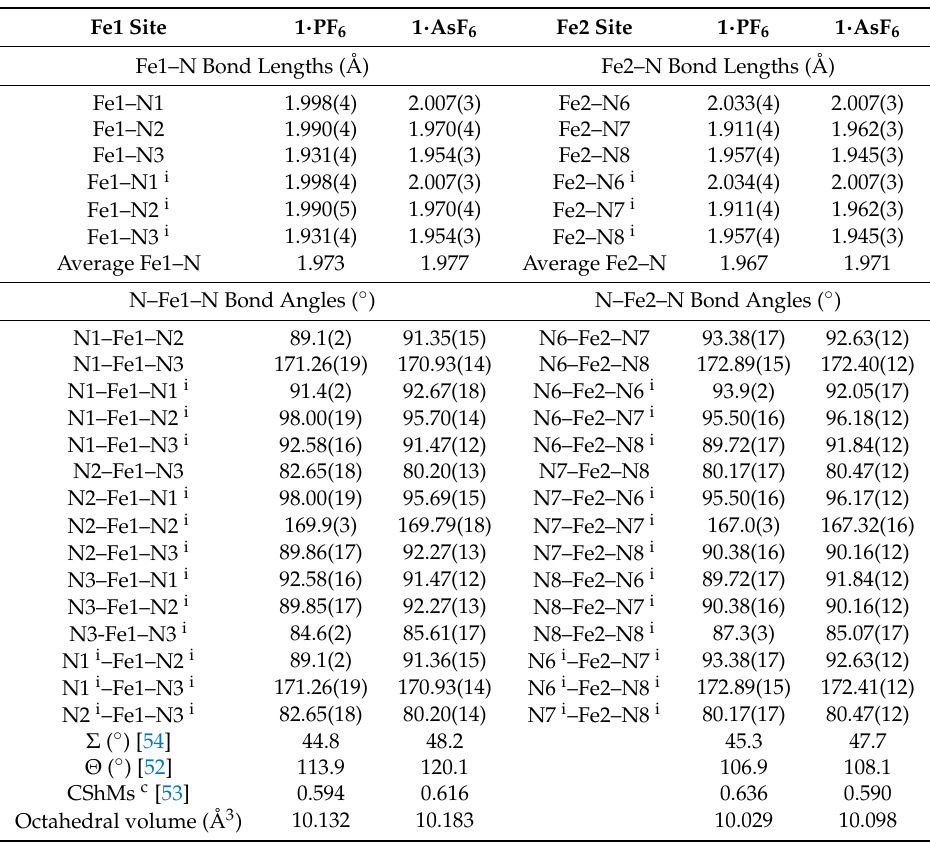
Table 2. Coordination bond lengths, angles, and structural parameters for 1 · PF 6 and 1 · AsF 6 at 120 K. CShMs: continuous shape measures.